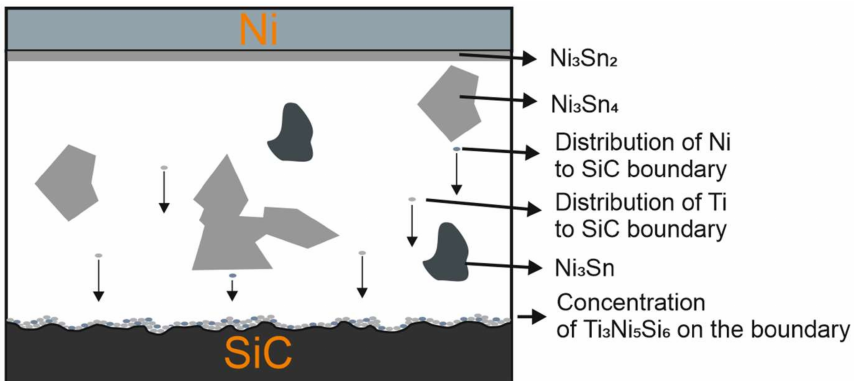
Figure 19. Mechanism of bond formation with Sn5Sb3Ti